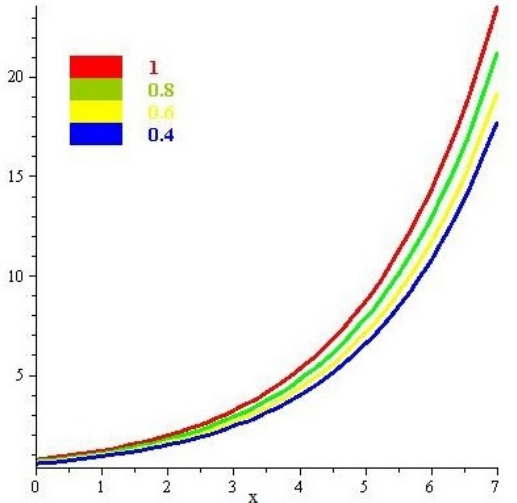
Figure 4. Solution graph of Example 1, at various value of γ